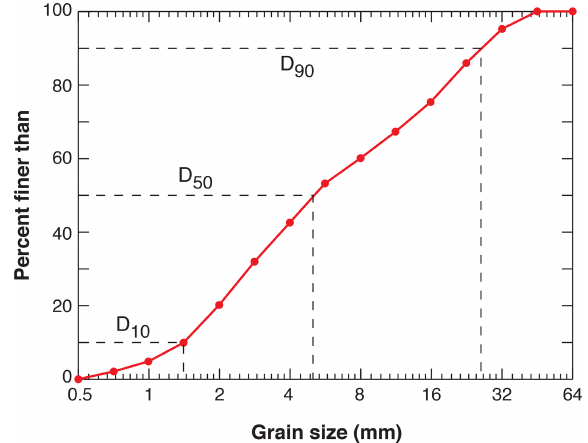
Figure 2. Grain size distribution of the bulk sediment used in the